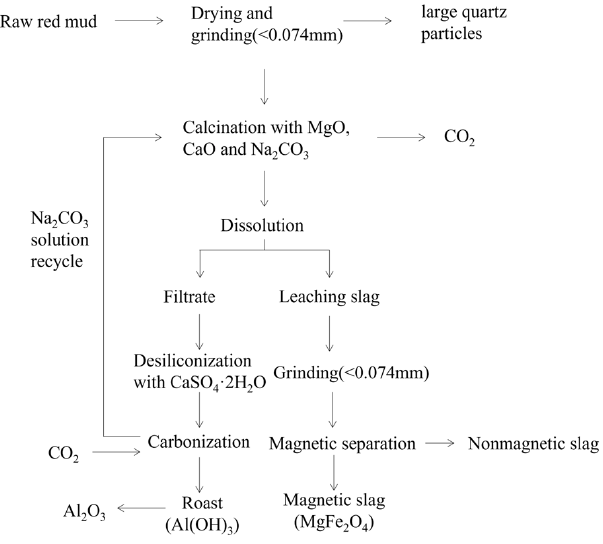
Figure 1. The fl owchart of the magnetic sintering process. Figure 1. The flowchart of the magnetic sintering process. According to a previous study [31], the slightly soluble CaSO 4 can be added for silica removal, carbonation, and solid roasting to recover calcium silicate, sodium carbonate, and high-purity alumina oxide, respectively. The reformed sodium carbonate can be recycled in the calcination process to reduce alkali consumption. The reactions occurred during the recovery of alumina and the recycling of filtrate were given in Equations (2)–(6) as